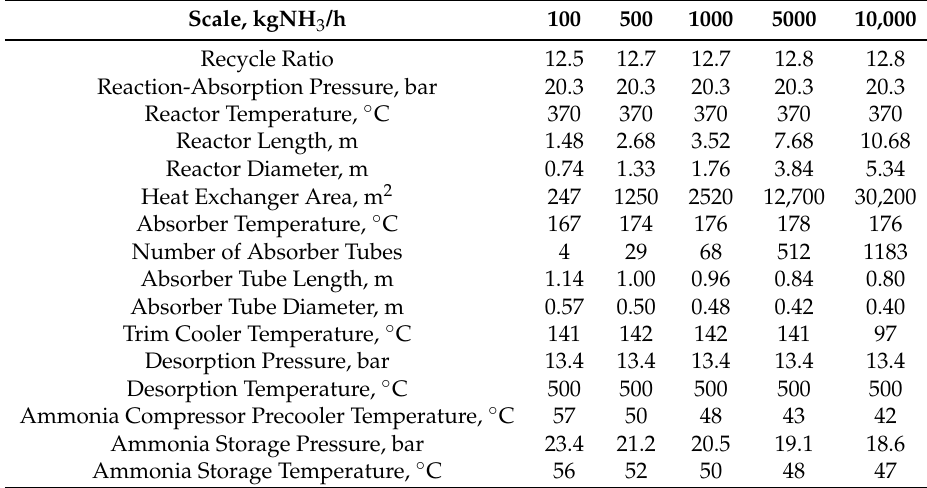
Table 10. Absorbent-enhanced ammonia synthesis optimal design decisions.